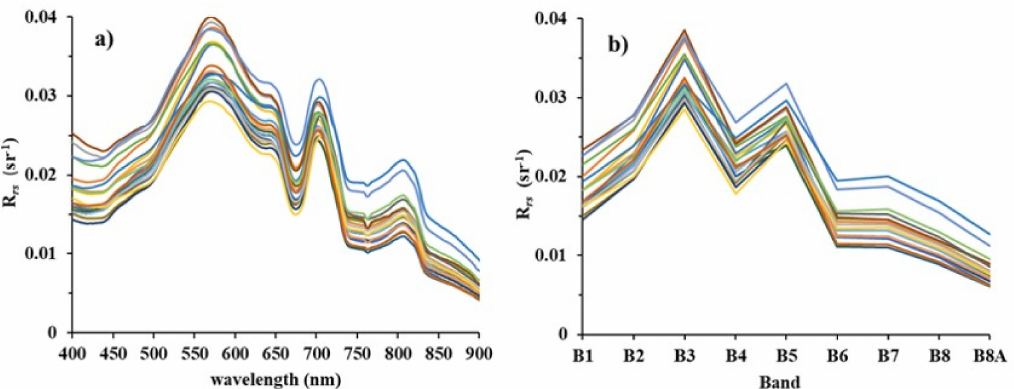
Figure 3. ( a ) Measured reflectance spectra of surface water, and ( b ) the equivalent reflectance spectra of Sentinel-2